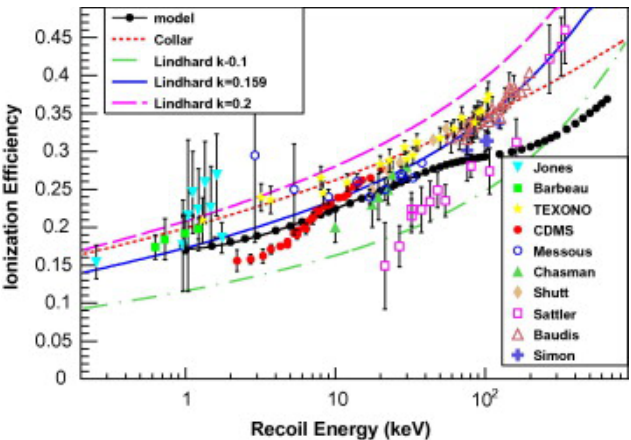
Figure 37: Comparison of ionization yield versus recoil energy for various models and experimental data. Models are Barker and Mei [ 48 ] , Collar [ 50 ] and Lindhard [ 45 ] Data points are from Jones and Kraner [ 49,51 ] , Barbeau et al. [ 50 ] , TEXONO [ 52 ] , CDMS [ 53 ] Messous et. al [ 54 ] , Chaseman et al. [ 55 ] , Shutt et. al [ 56 ] , Sattler et al. [ 57 ] , Baudis et. al [ 58 ] , and Simon et.a l [ 59 ] . Figure adapted from [ 48 ] .